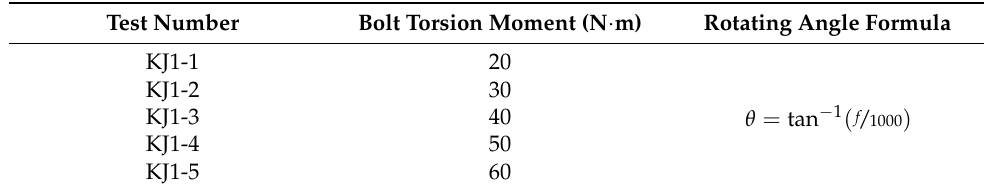
Table 2. Test instrument